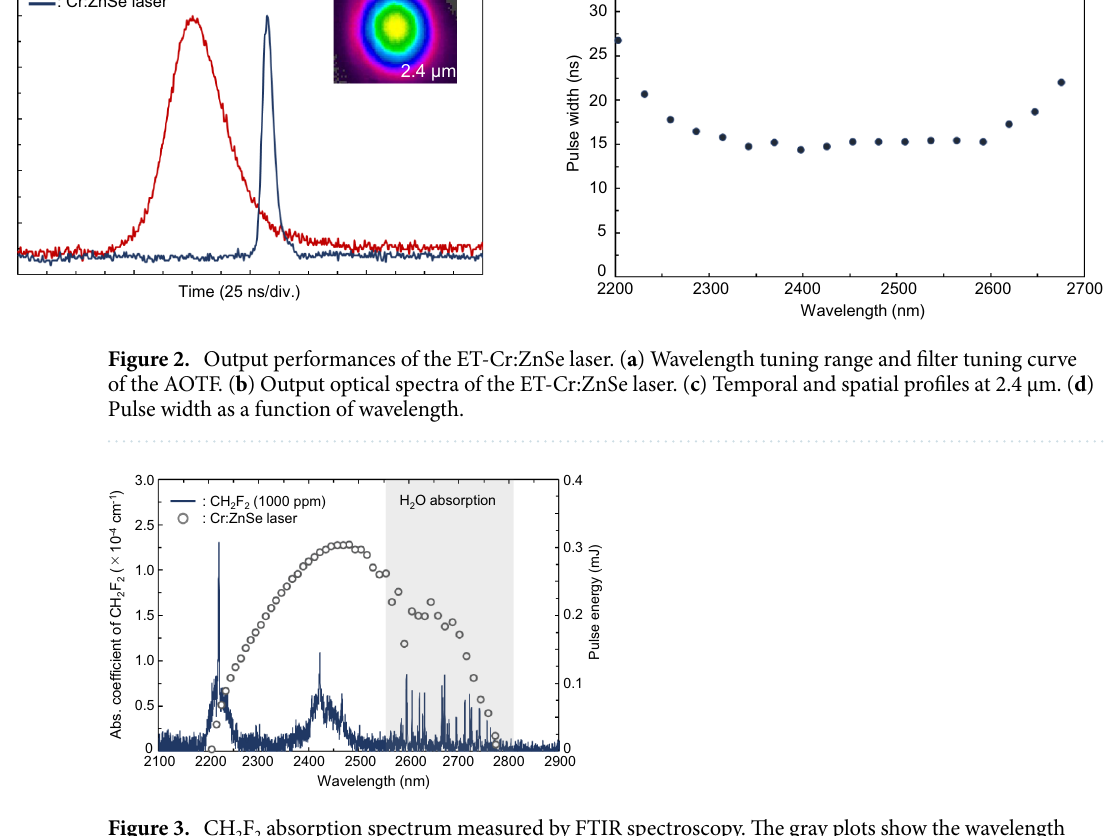
Figure 3. CH 2 F 2 absorption spectrum measured by FTIR spectroscopy. The gray plots show the wavelength tuning range of the ET-Cr:ZnSe laser. The absorption spectrum of H 2 O was also observed in 2550–2800 nm. The gas pressure inside the gas cell was set to 1